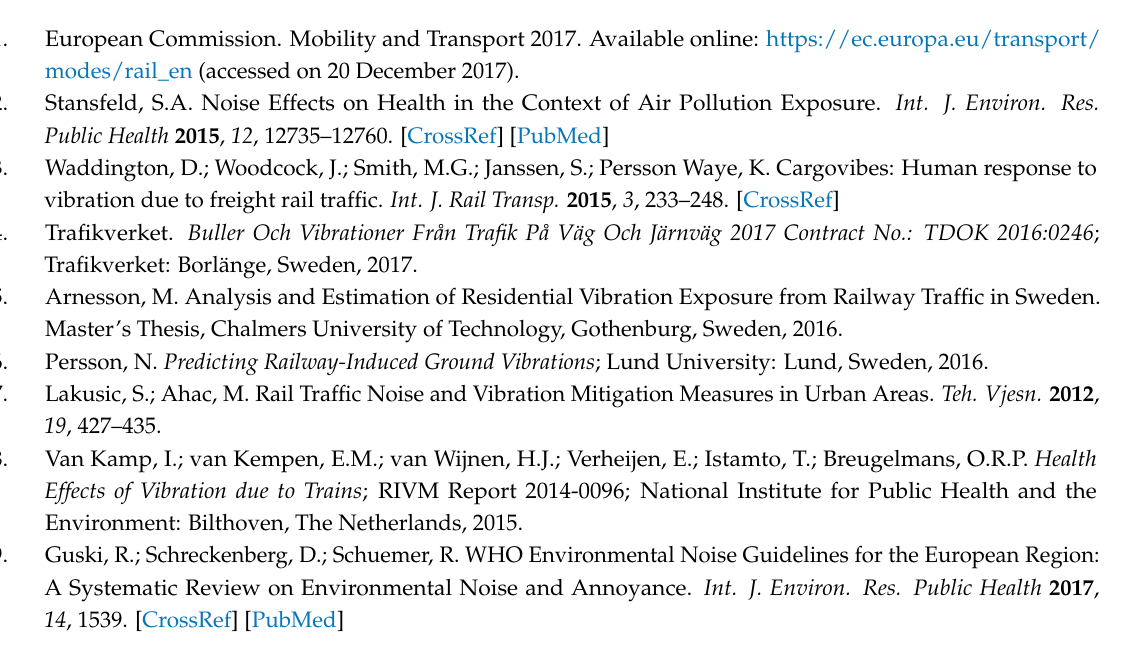
Table S1. Overview of response in relation to distance from the railway, Table S2. Odds of being annoyed by vibrations stratified by distance and train type with moderating factors (full version of Table 3), Table S3. Odds of being highly annoyed by vibrations stratified by distance and train type with moderating factors (full version of Table